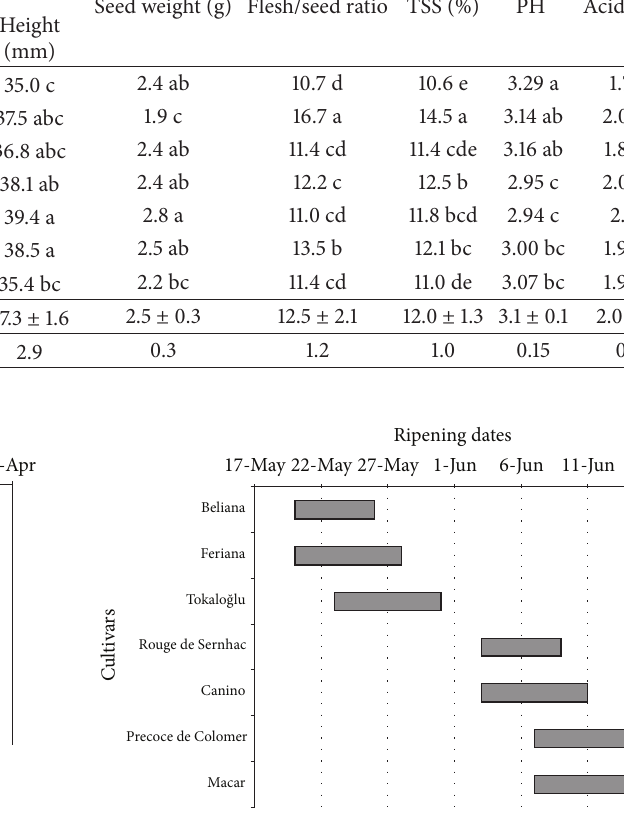
Figure 3: Maturation dates of the apricot cultivars (average of four